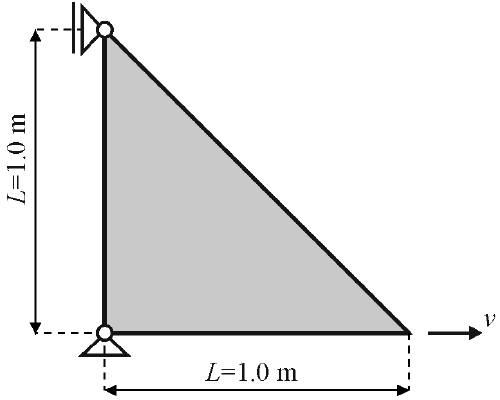
Figure 6. Triangular finite element under uniaxial loading.